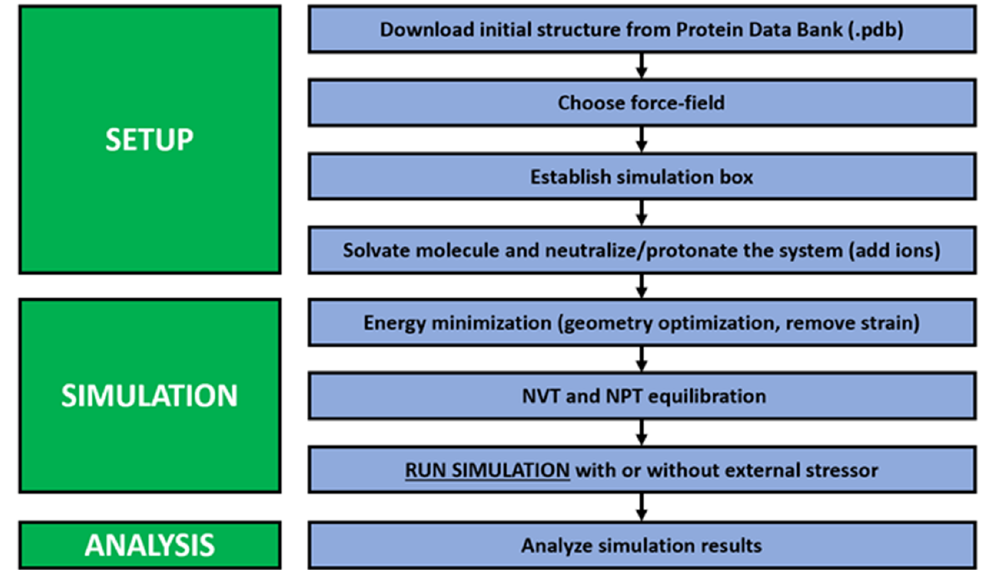
Figure 1. General steps to run a GROMACS MD simulation.